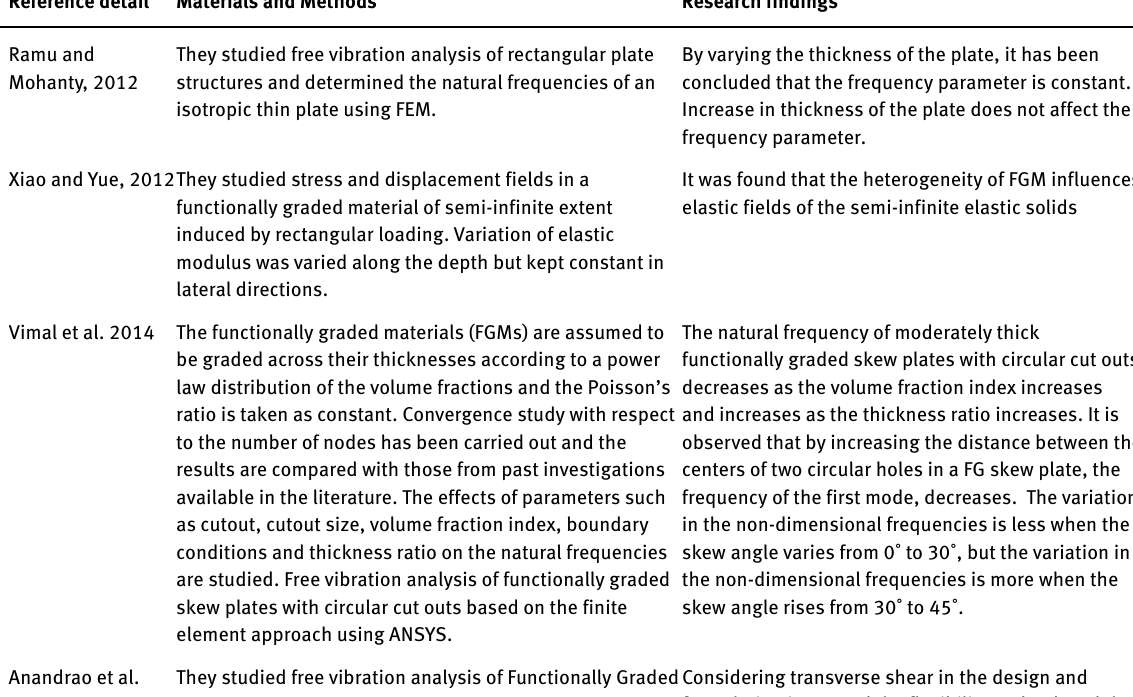
Table 1: Important findings of studies on vibration analysis of functionally graded materials Sl. no. Reference detail